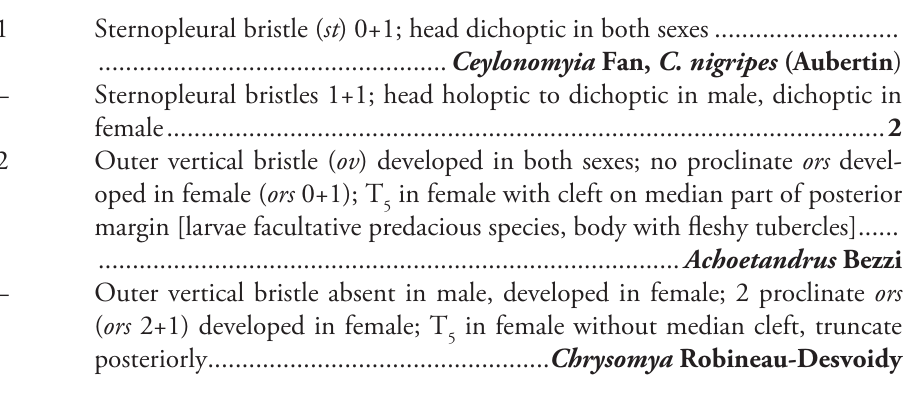
margin [larvae facultative predacious species, body with fleshy tubercles]